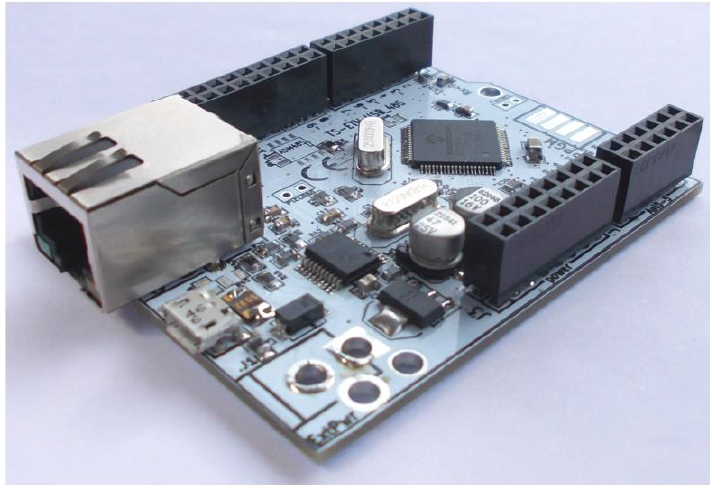
Figure 24. The P18_E_SP_FTC_485 12_13_9_2 board.